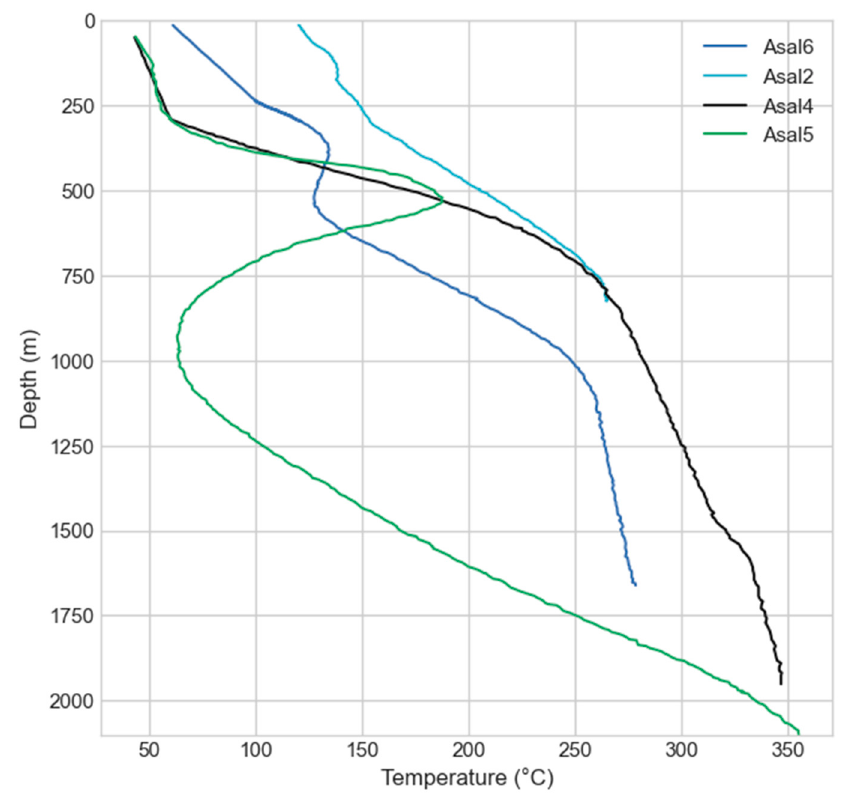
Figure 2. Temperatures measured at equilibrium in Asal geothermal wells.